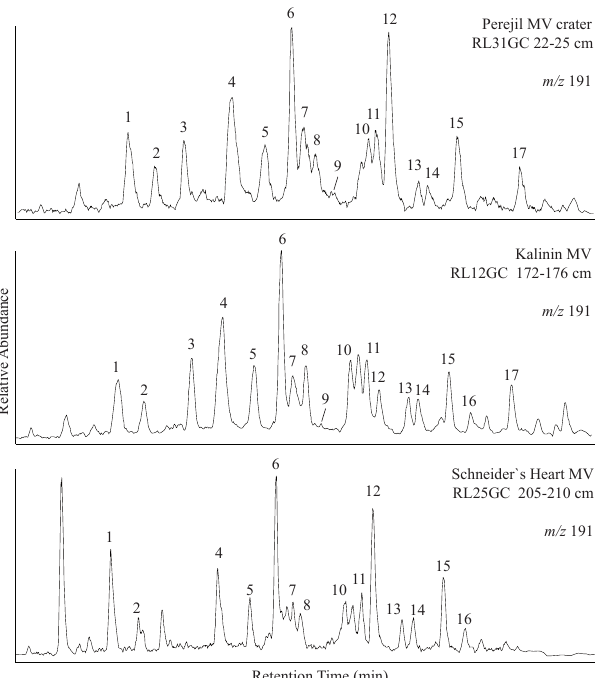
Figure 4. Typical m/z 191 mass chromatograms showing distribu- tions of pentacyclic triterpenoids present in selected mud breccia samples of Perejil, Kalinin and Schneider’s Heart MVs. Numbers refer to compounds listed in Table 3.